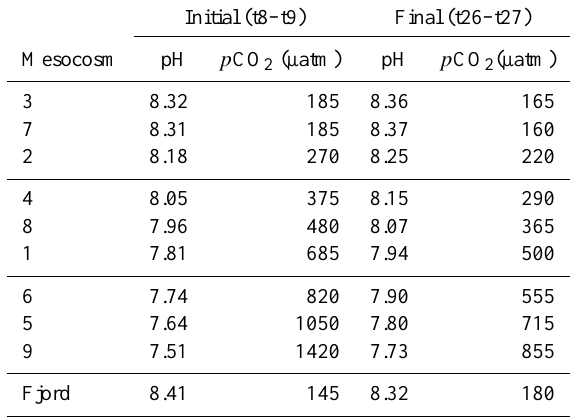
Table 1. pH (on the total scale) and p CO 2 levels in the nine meso- cosms at the start and the end of the experimental period. No CO 2 was added to mesocosms M3 and 7; they served as